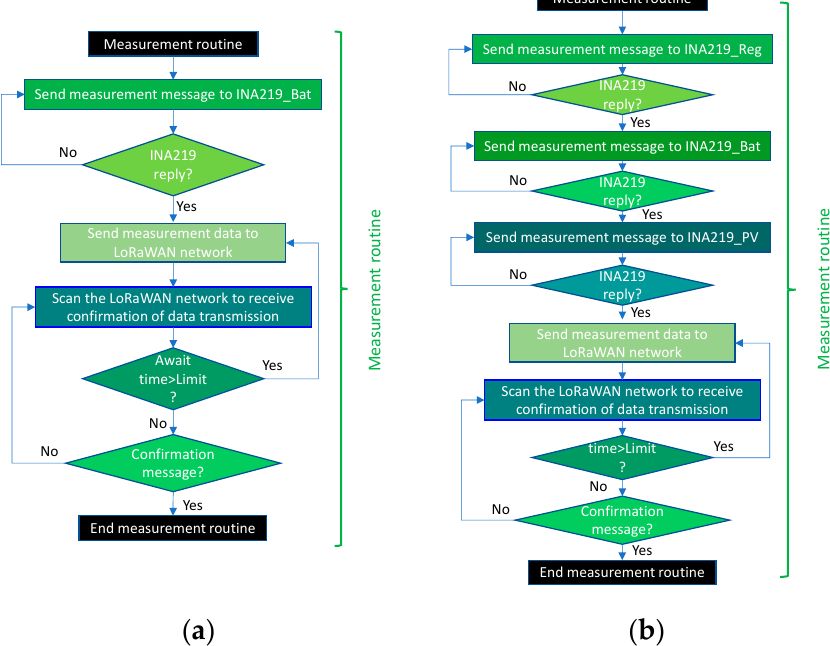
Figure 17. Flow chart of the measurement routines for the ECDL: ( a ) battery power supply and ( b ) battery and solar panel power supply. As with other routines, the data modification routine is based on the one described for the THMDL. In this case, only two variables are needed: (i) timeout for receiving and sending messages and (ii) minimum voltage for sending low battery warnings. Figure 18 shows the parameter change routine for the ECDL.